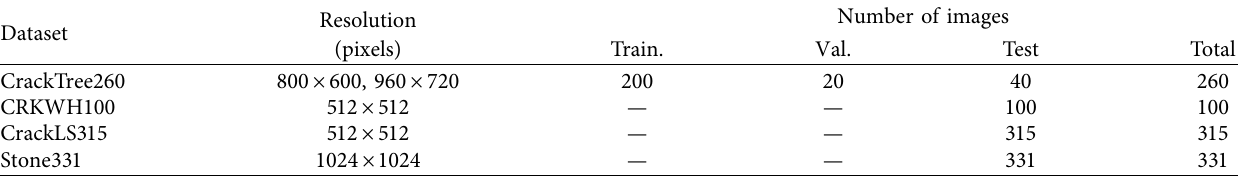
Table 2: Summary of the four crack datasets used in this